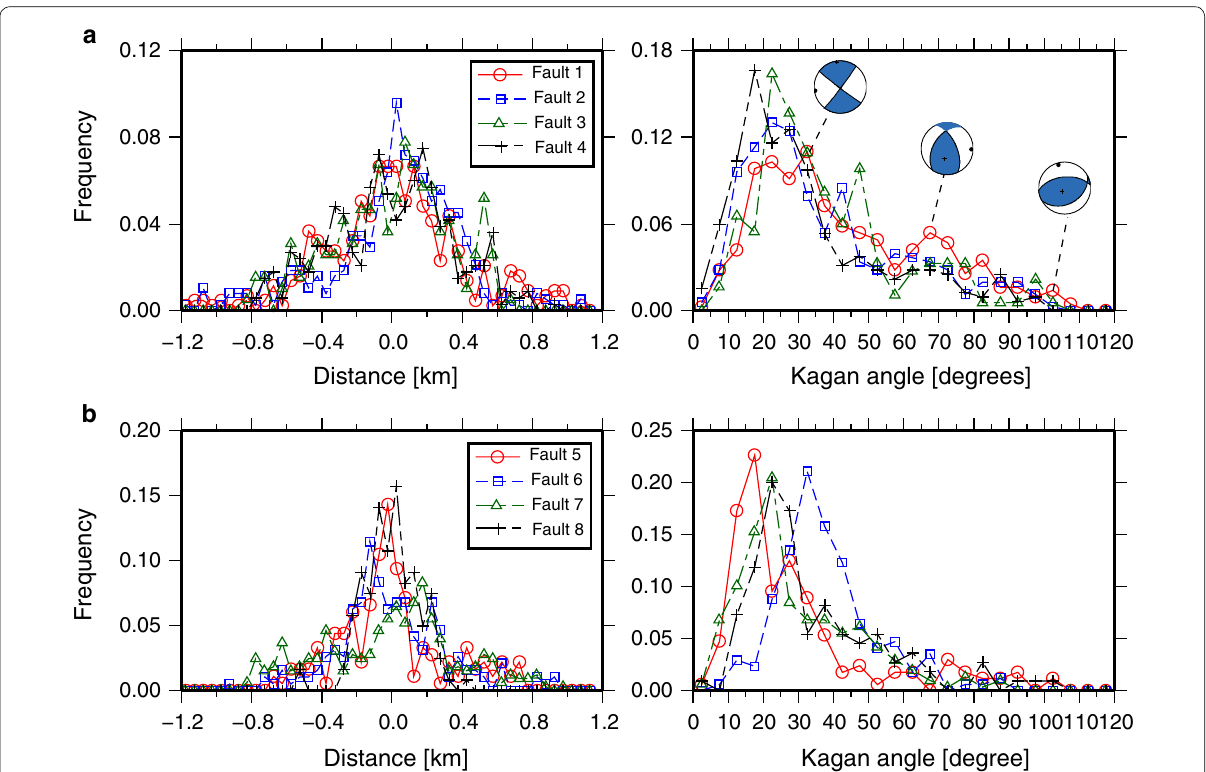
Fig. 6 Histograms showing the distance from the best-fit fault planes and the Kagan angles. ( Left ) The distance from the best-fit fault plane to each location of an aftershock. ( Right ) The Kagan angles from the reference focal mechanism. The Y -axis is normalized by the total number of events. a Faults 1 through 4, b Faults 5 through 8. Some examples of focal mechanisms around Fault 1 at the Kagan angle are also shown in ( a